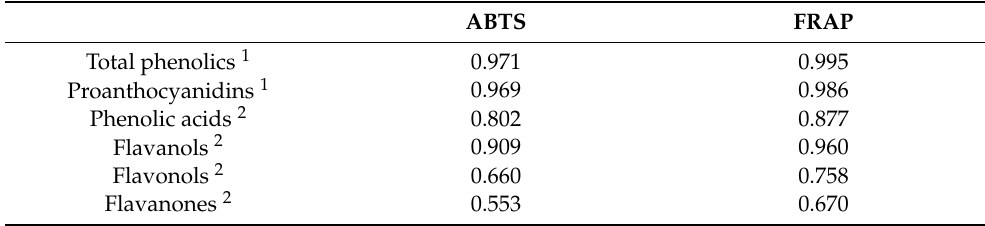
Table 5. Pearson’s correlation coefficients (R) between the phenolics contents and antioxidant capacity and anti-lipase activity of chokeberry fruits with different stages of